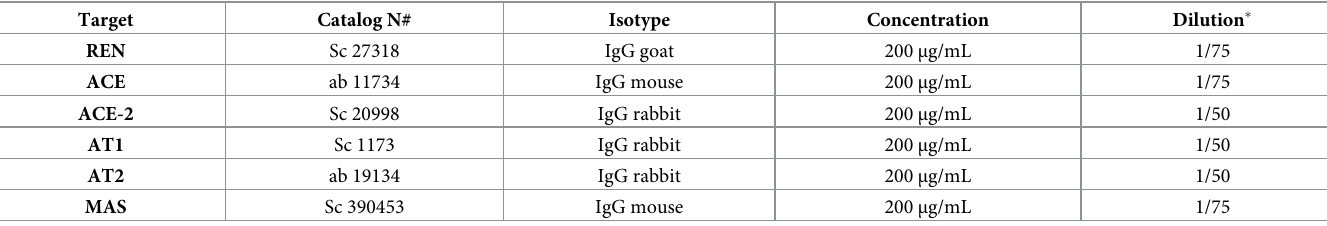
Table 2. Origin, isotype, concentration and dilution of the primary antibodies used for the immunohistochemical staining.